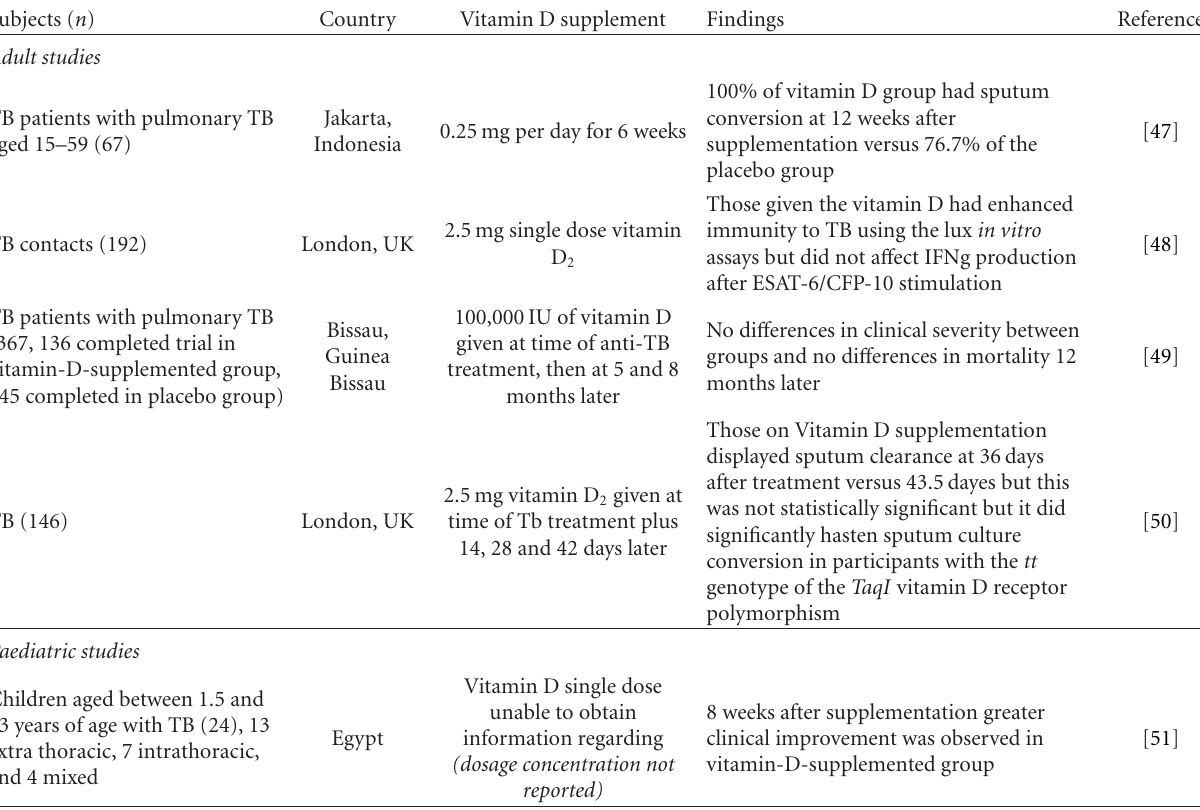
Table 2: Vitamin D single dose (dosage concentration not